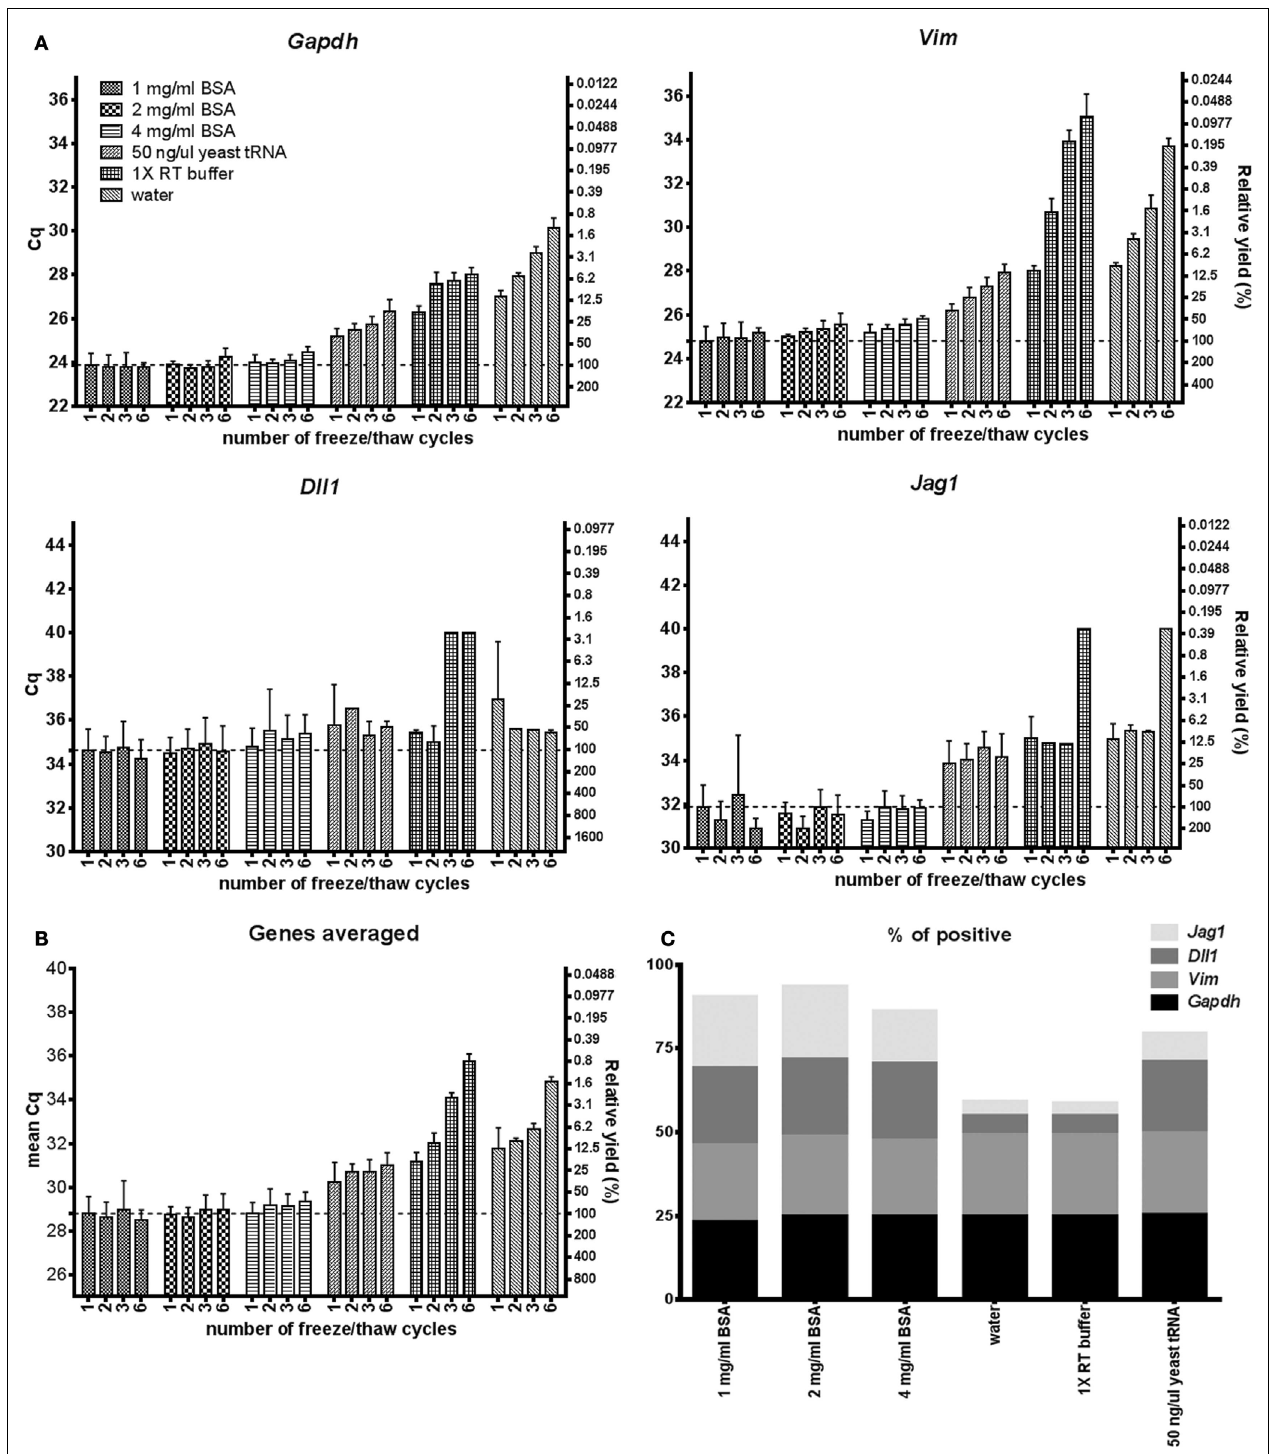
efficiency. Data are shown as mean ± SD ( n = 4) (B) Mean RNA accessibility of the transcripts. Expression of Gapdh , Vim , Dll , and Jag1 were averaged and compared to the 1mg/ml BSA sample thawed once. (C) Percentage of positive data points. Missing data were excluded from subplot (A,B) and are shown inTable S6 in Supplementary Material. Four genes and four different amounts of freeze/thaw cycles were analyzed per lysis condition. GTC, guanidine thiocyanate; 1 × RT buffer, 1 × reverse transcription